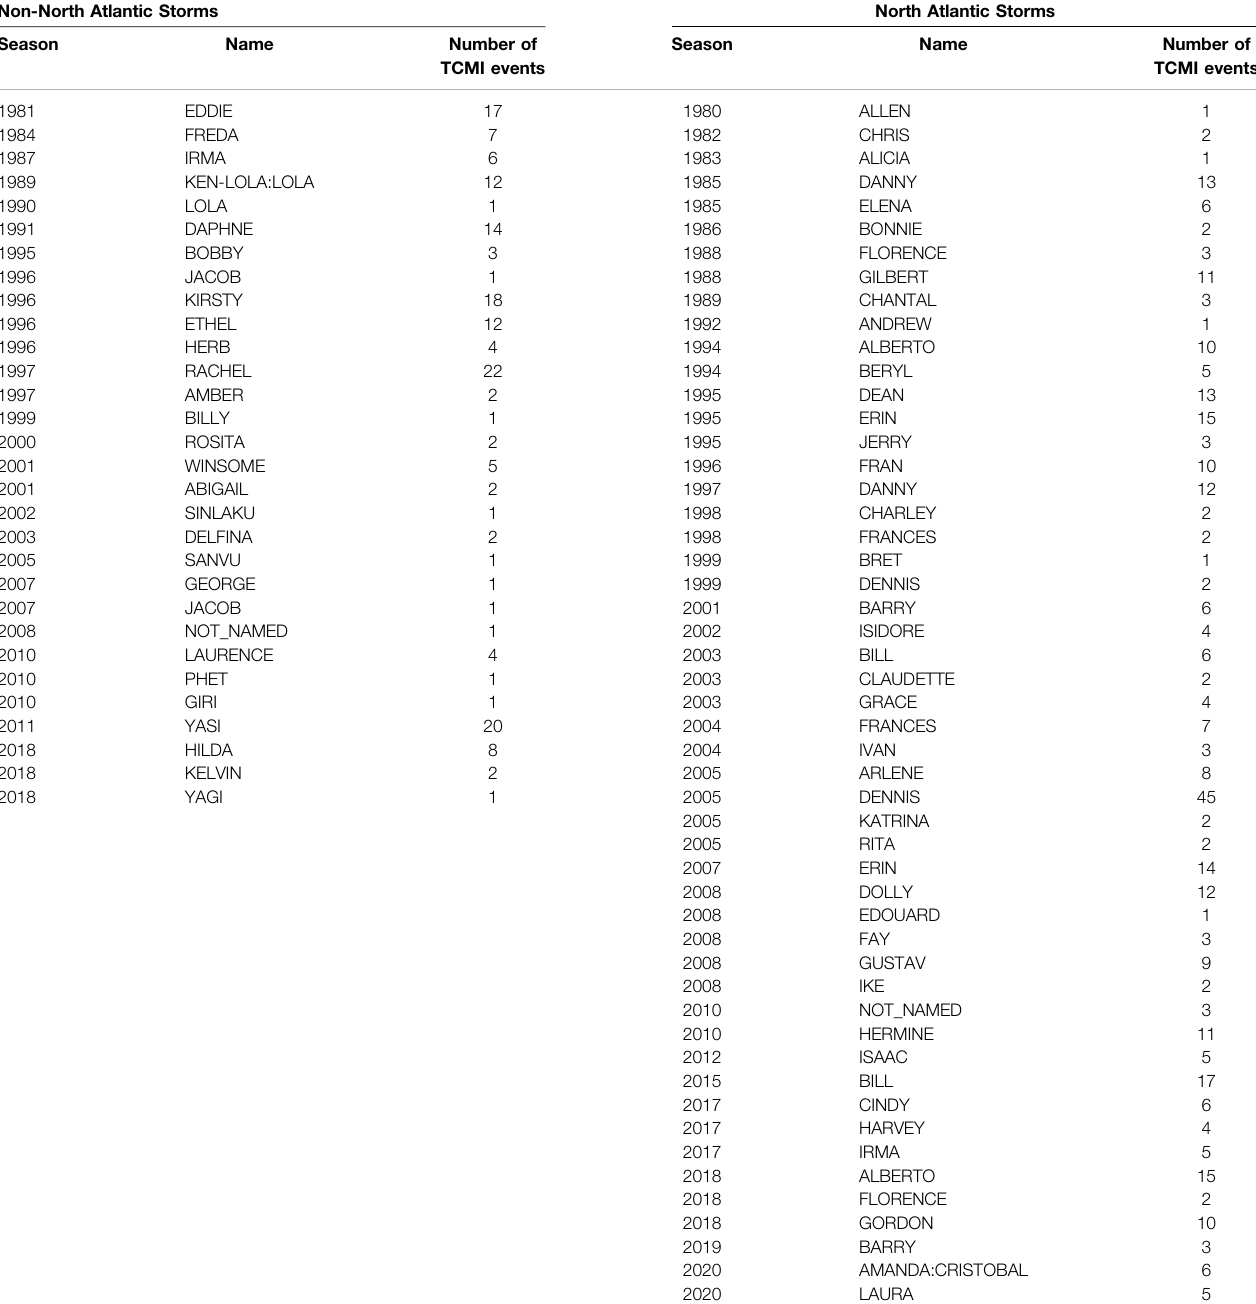
TABLE 3 | Tropical cyclones that Underwent